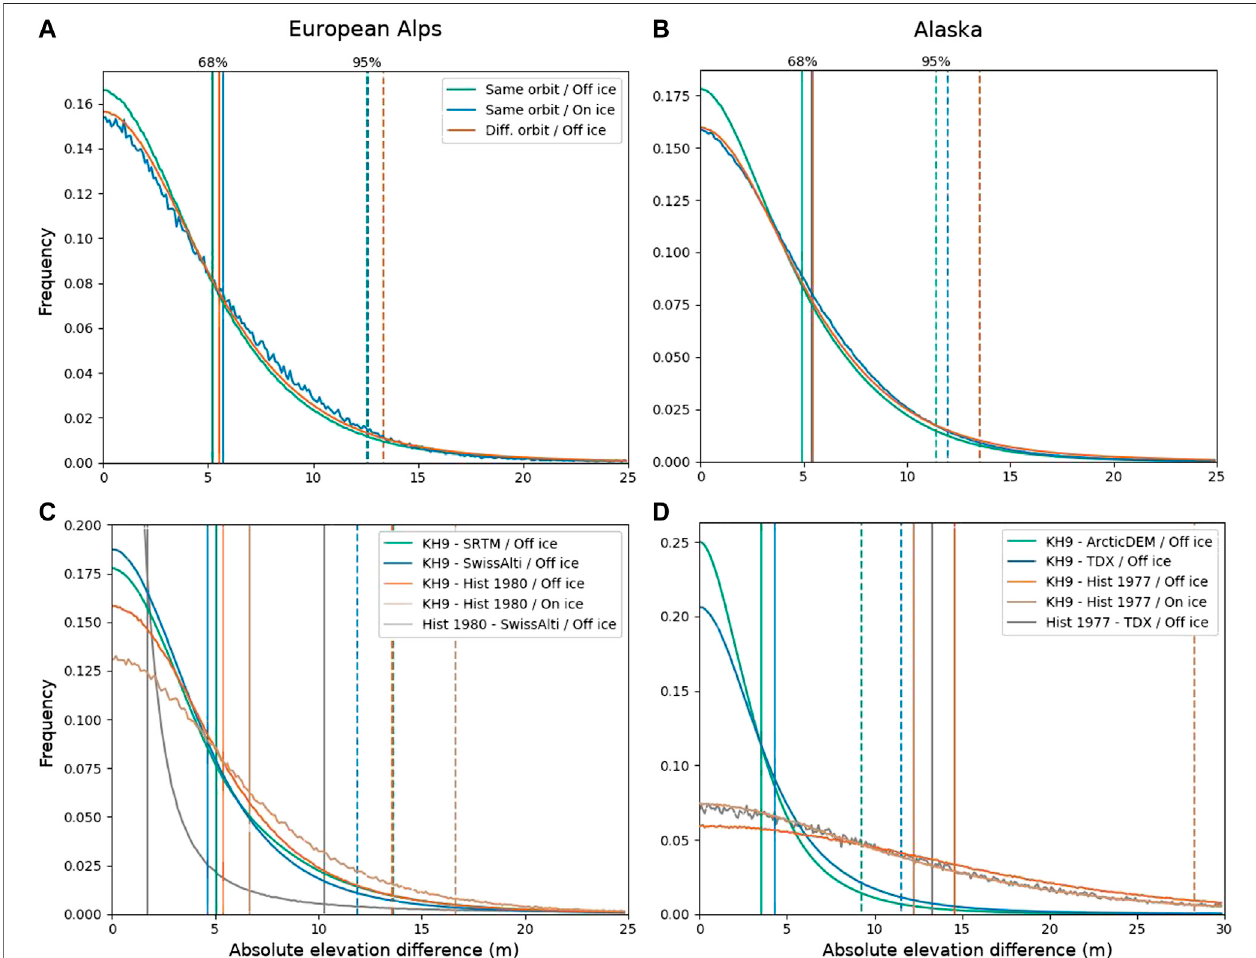
FIGURE8| DistributionsofabsoluteelevationdifferencesforKH-9MCDEMsovertheAlps(leftcolumn,8DEMs)andAlaska(rightcolumn,48DEMs).Thetoprow (A,B) showstheelevationdifferencebetweenoverlappingKH-9MCDEMsfromthesameorbit(samedate)ordifferentorbits.Thebottomrow (C,D) showstheelevation difference between the KH-9 MC DEMs and several ancillary DEMs. Solid and dashed vertical lines indicate the 68th and 95th percentiles of the distributions, respectively.